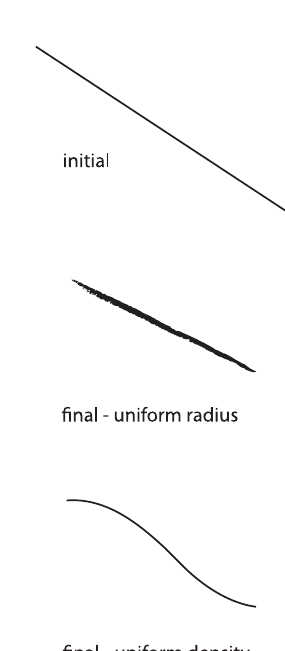
FIG. 15. Longitudinal phase space ( v vs z ) evolution for z the ideal cases. Top—initial phase space for both two cases, with linear tilt and no temperature. Middle—uniform radius case showing increase in thickness of the phase space as a growth of temperature. Bottom—uniform density case showing a head-to-tail distortion (S-ing) results in a growth of effective